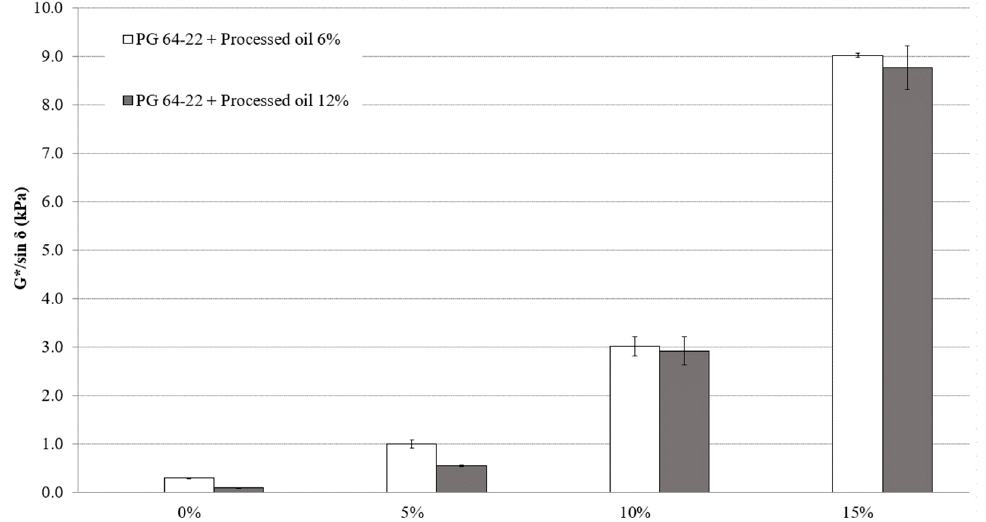
Figure 5. G*/sin δ of RTFO aged PG 64-22 binders with processed oil as a function of SBS content at 82 °C.